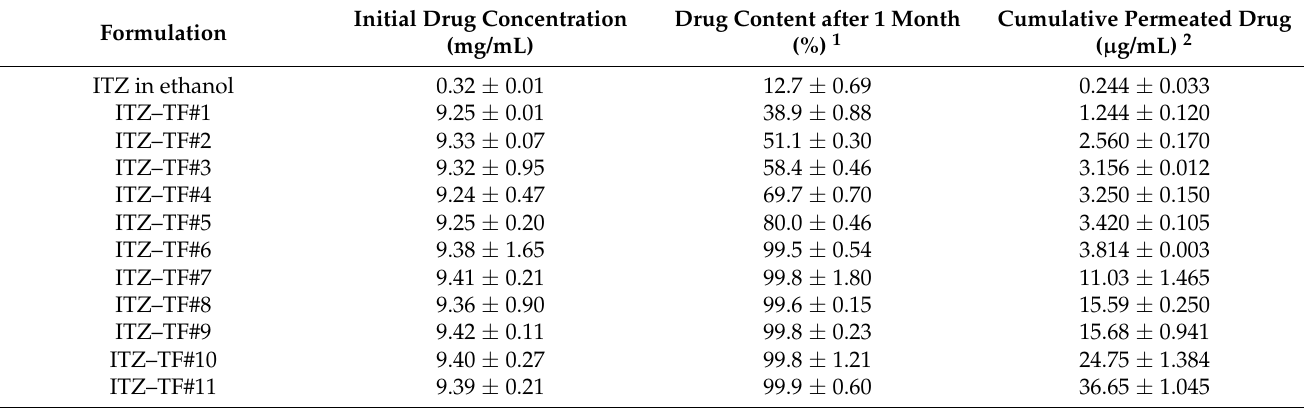
(Table 3) [20]. Moreover, ITZ–TF#11 was able to maintain the drug content within the range of 95.0–105.0% for more than 90 days, and no changes in physical appearance (e.g., precipitation, phase separation, or color change) were observed. Table 3. Initial drug concentration, drug content after 1 month, and cumulative permeated drug from ITZ–TF through the artificial skin